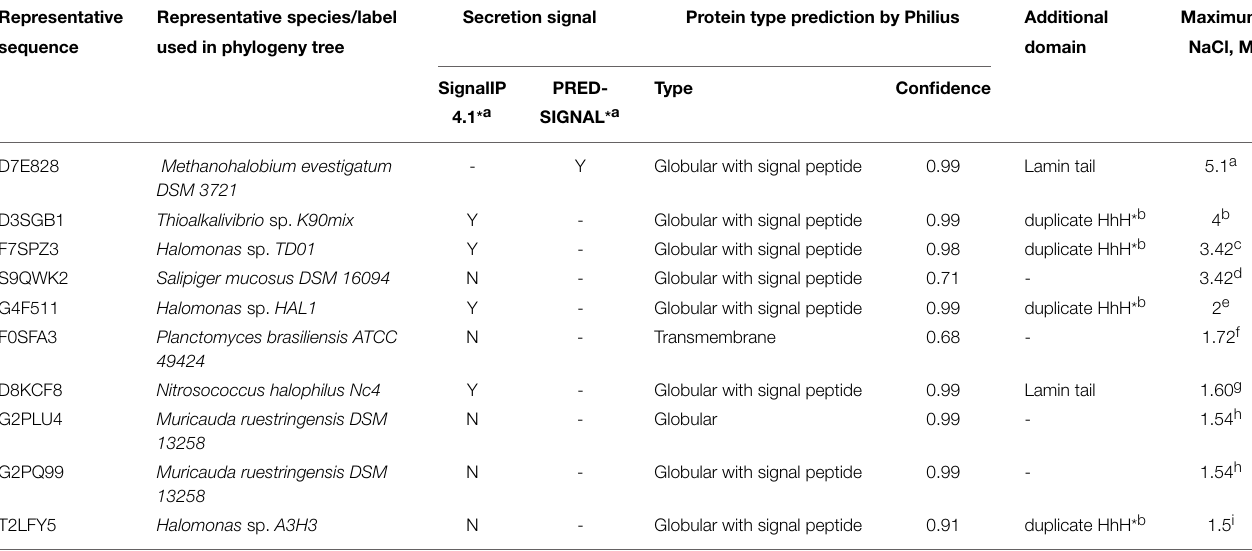
TABLE 1 | The secretion signal in DNases from the most salt tolerant organisms ( (cid:2) 1.5 M NaCl).